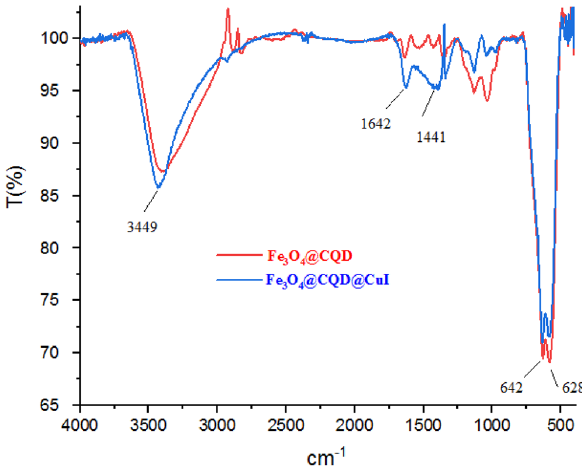
Figure 3. FT-IR spectra of Fe 3 O 4 @CQD and Fe 3 O 4 @CQD@CuI in KBr.